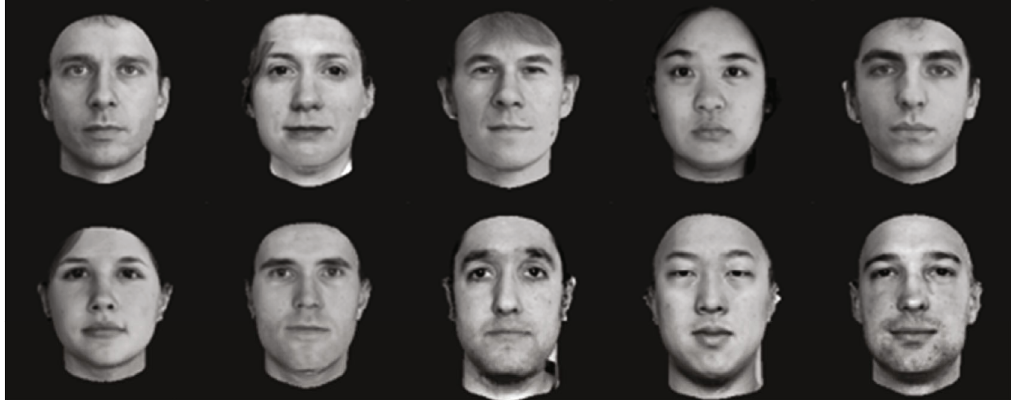
Figure 1: Subjects in the MIT (2003-2005) database.